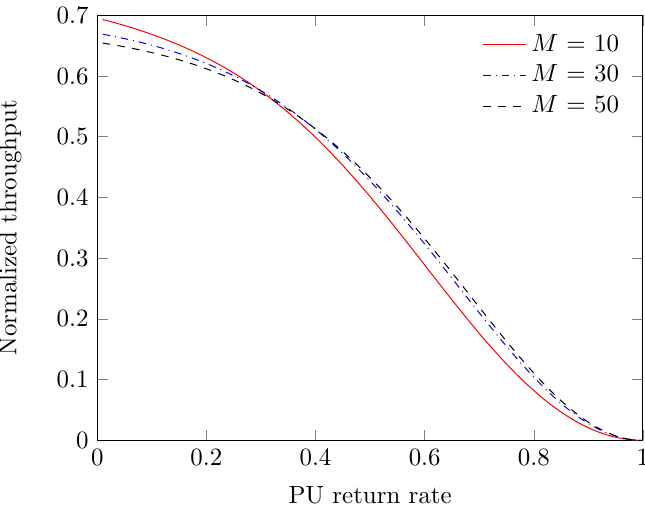
Figure 10. Normalized throughput vs. PU return rate.